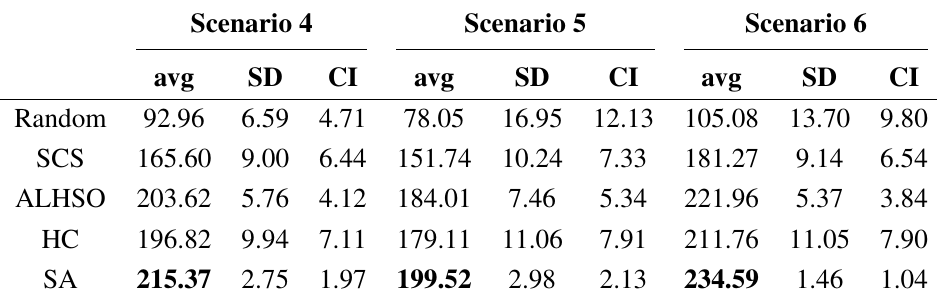
Table 4. Utility in scenarios with 50 APs and 500